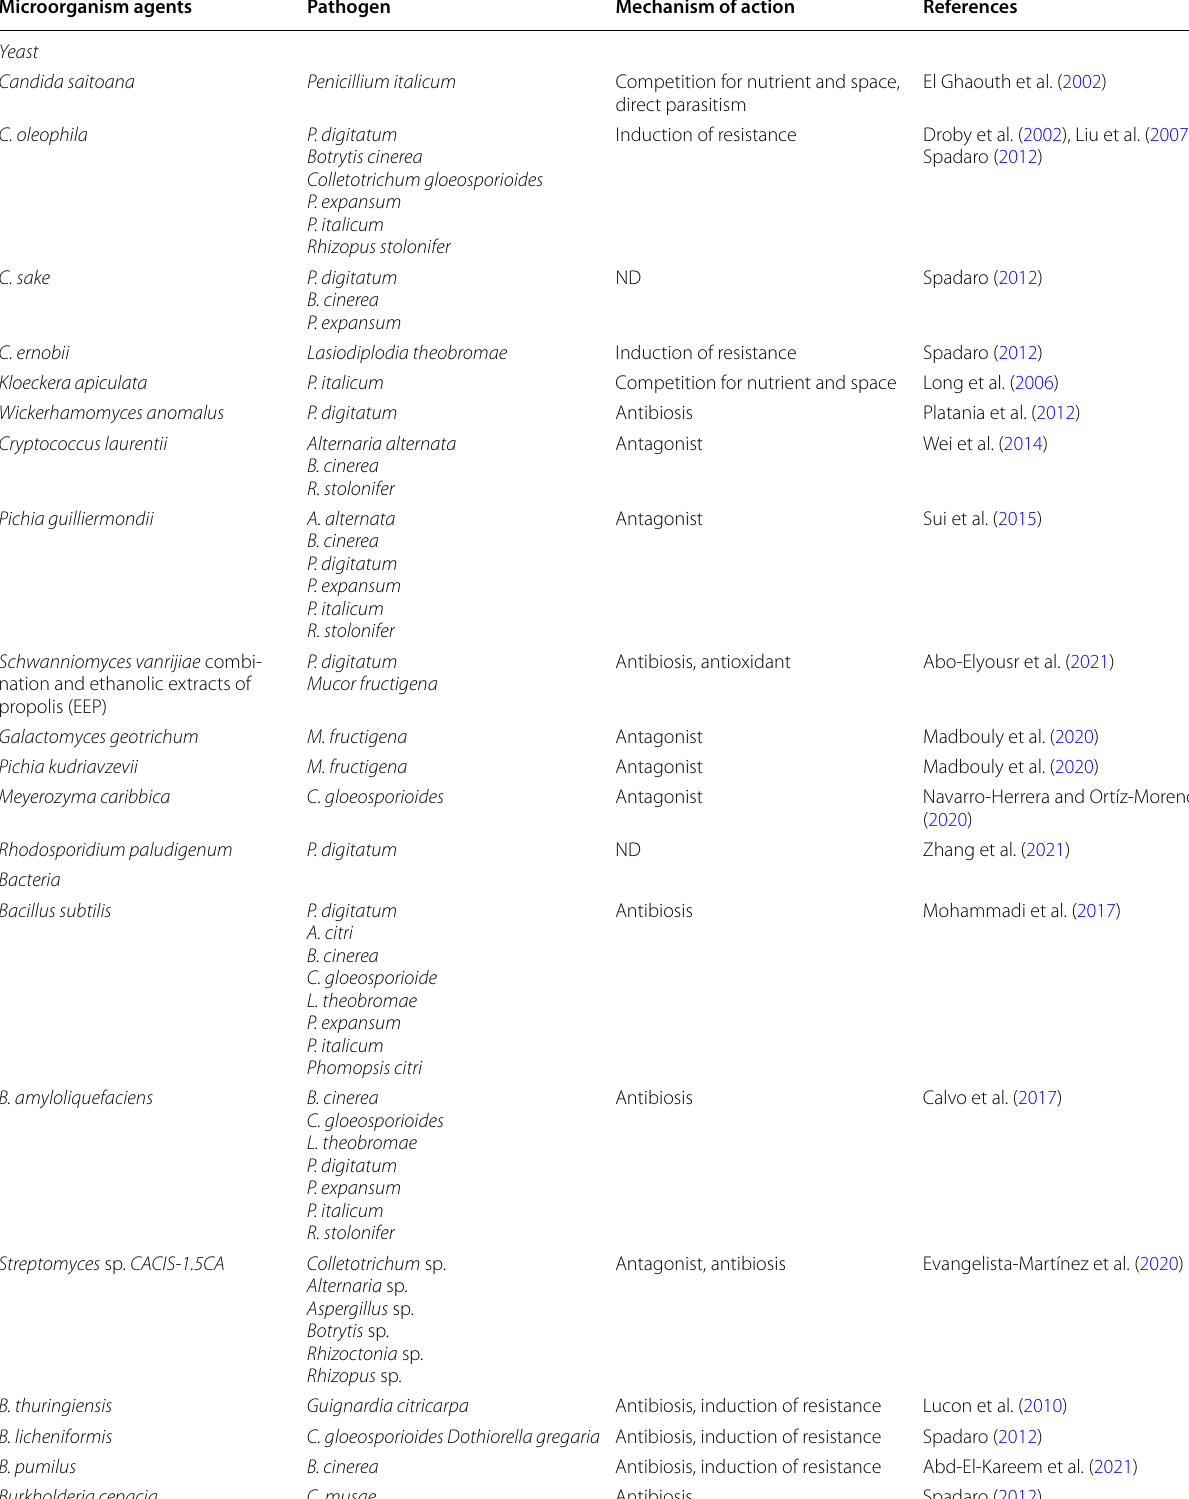
Table 3 Microorganism agents used for the successful control of postharvest diseases of citrus, apples, grapes, and strawberries Microorganism